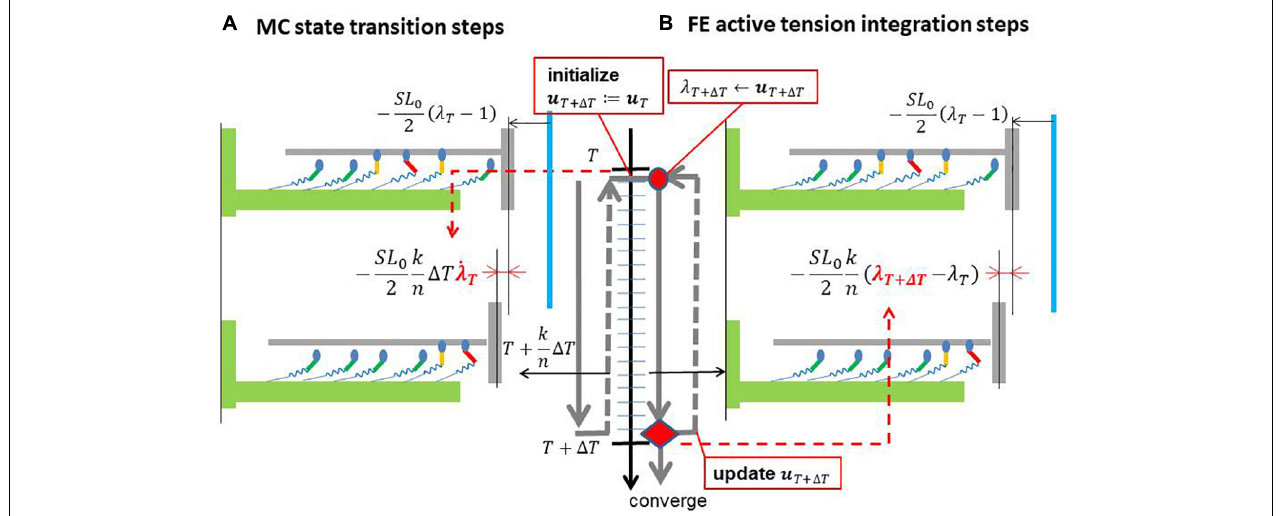
FIGURE 3 | Difference between the sliding distances of the thin filament in (A) the MC state transition steps and (B) the FE active tension integration steps. An FE time interval [ T , T + (cid:49) T ] is divided into n MC multiple steps ( k = 1 , ··· , n ) . The vertical blue line is the position of the Z-line under the unloaded condition. The sliding distances in [ T , T + (cid:49) T ] are extrapolated from the sliding velocity −˙ λ T · SL 0 / 2 at T in the MC steps, whereas they are interpolated from the stretches λ T and λ T + (cid:49) T at T and T + (cid:49) T in the active tension integration steps, respectively. The gray arrows around the time axis indicate the flow of the computational process. The MC state transition steps are performed only once from T to T + (cid:49) T , whereas the FE active tension integration steps are iterated until the convergence of Newton iterations, where λ T + (cid:49) T is computed from the updated displacement u T + (cid:49) T . Note that u T + (cid:49) T is initialized with u T at the beginning of the Newton iterations in this